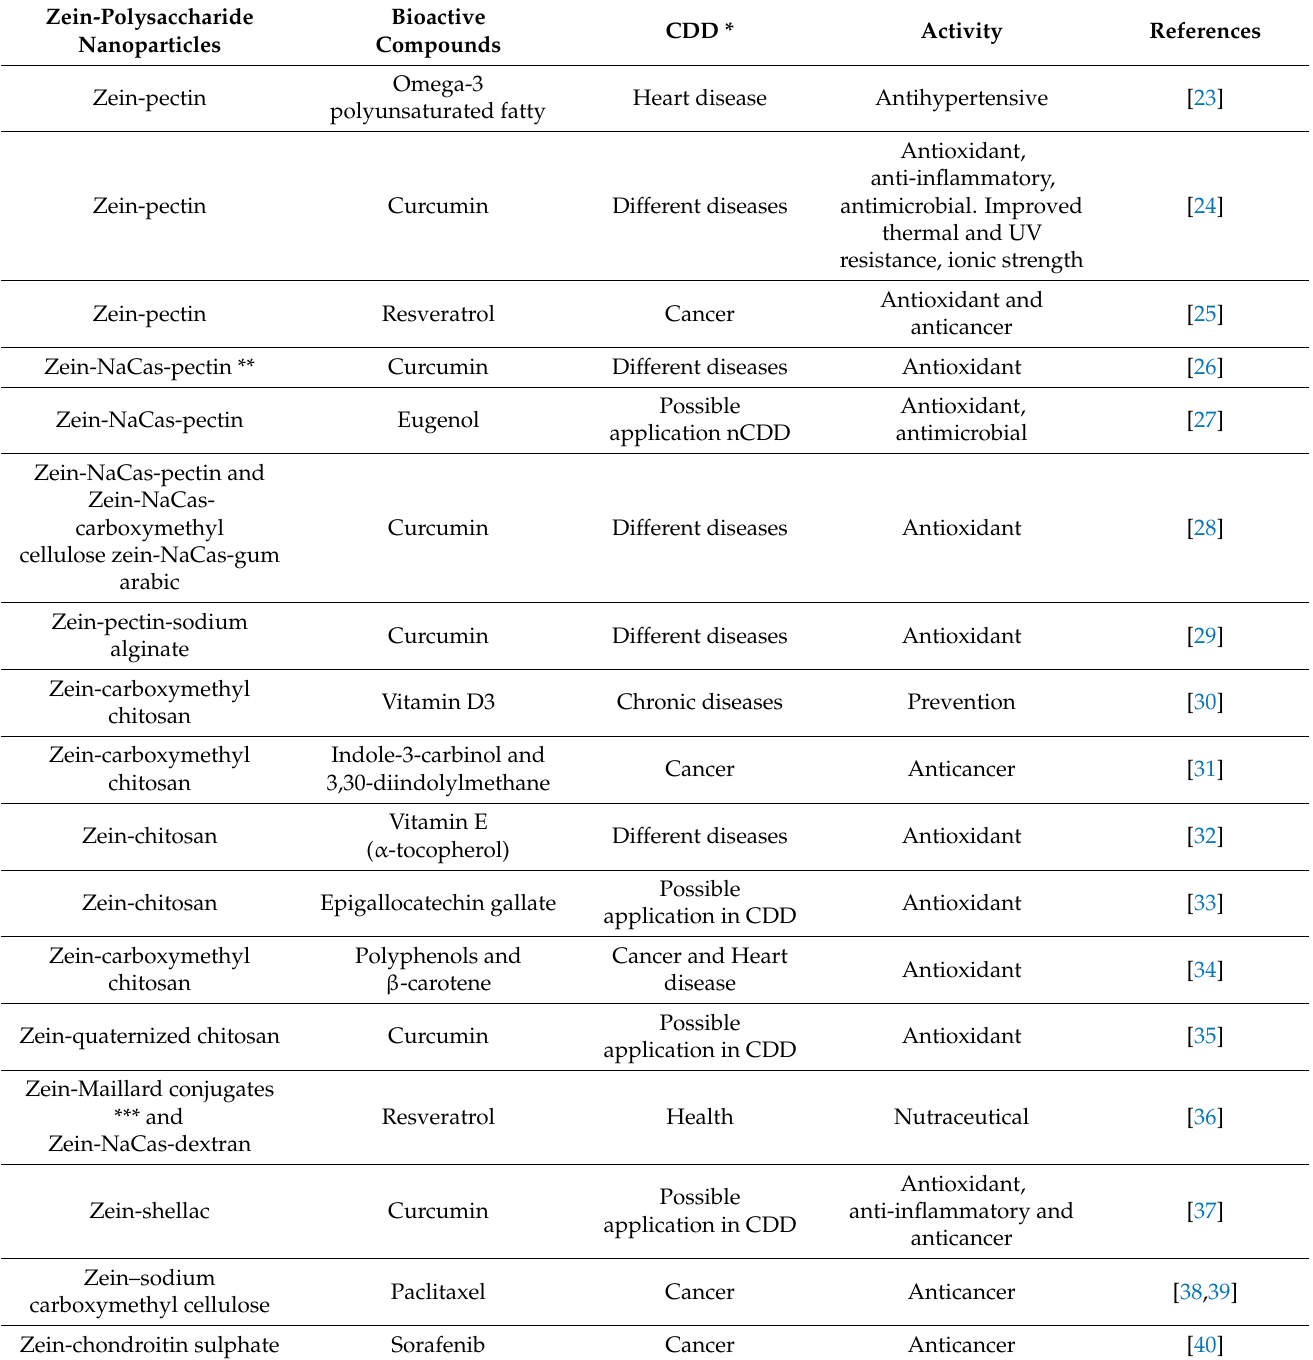
Table 1. List of polysaccharides used to stabilize zein nanoparticles intended for treating chronic degenerative diseases (CDD). Reprinted with permission from ref. [22]. Copyright 2018